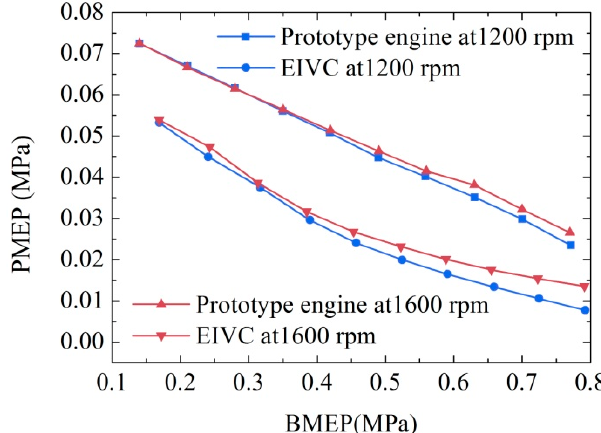
Figure 20. The PMEP of the prototype engine and the EIVC strategy.